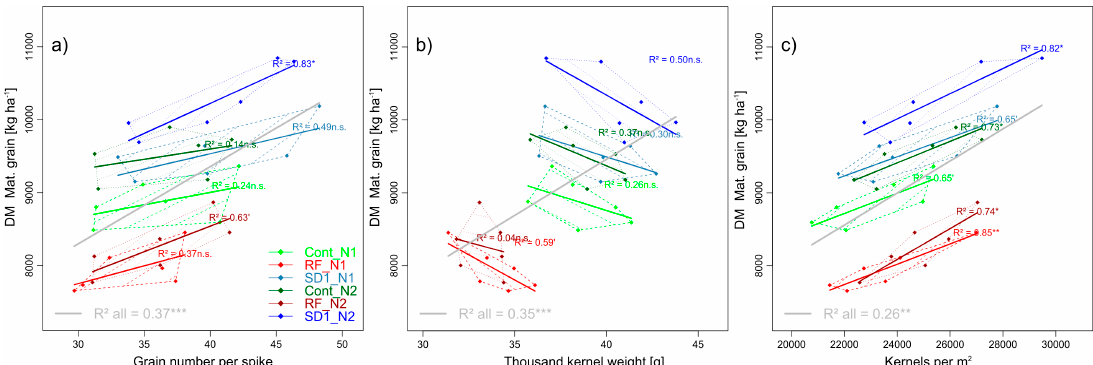
Figure 3. Selected pairwise trait relationships in trait complex b : DM of grain at maturity (GY) in relation to the direct yield components grain number per spike ( a ) and thousand kernel weight ( b ) and the combined yield component kernels per m² ( c ). N levels are distinguished by line types and color intensities (N1: Dashed lines and light colors, N2: Dotted lines and dark colors). Dashed and dotted lines delimit the bivariate data range covered by cultivars within MP × N-combinations. Colored regression lines indicate the linear trait relationships within MP × N-combinations and gray lines the regression line for the whole trial, calculated across the included data of reduced fungicide (RF), control (Cont) and sowing date 1 (SD1). Gray lines are only drawn for significant relationships ( p < 0.05). P -values of regression slopes are indicated as p < 0.01 (***), p < 0.01(**), p < 0.05 (*) and p < 0.1 (´).